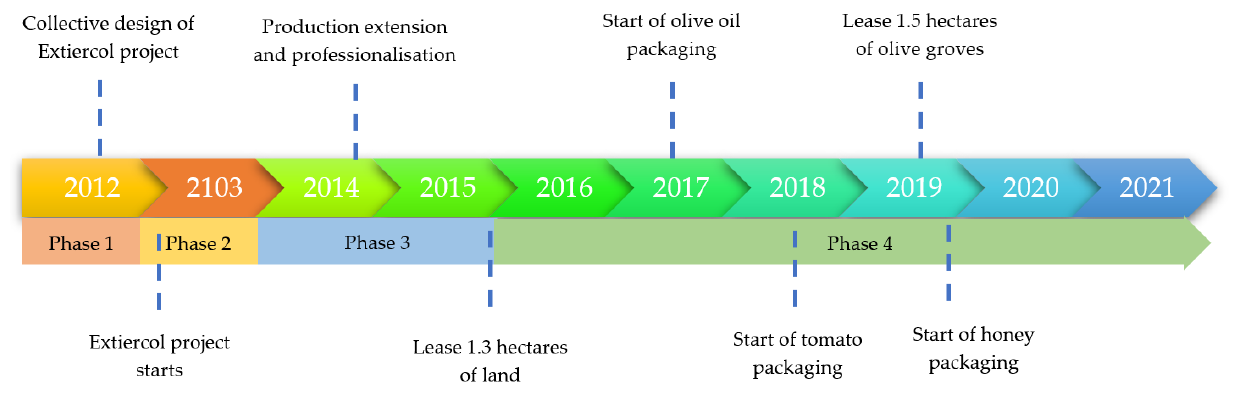
Figure 3. Historical steps in Extiercol project.